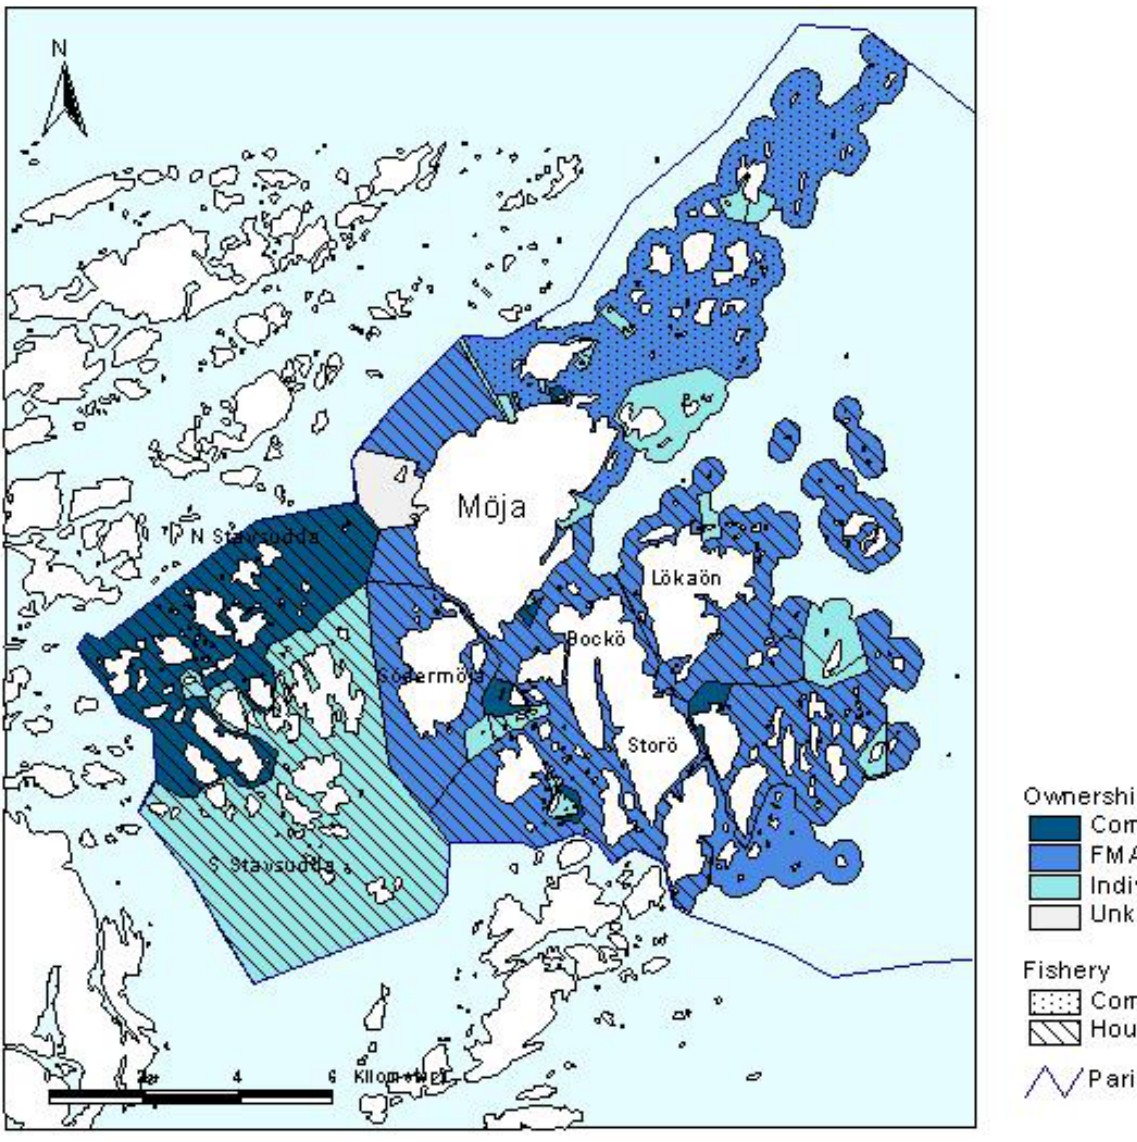
Fig. 3 . Distribution of ownership and fishery categories in Möja